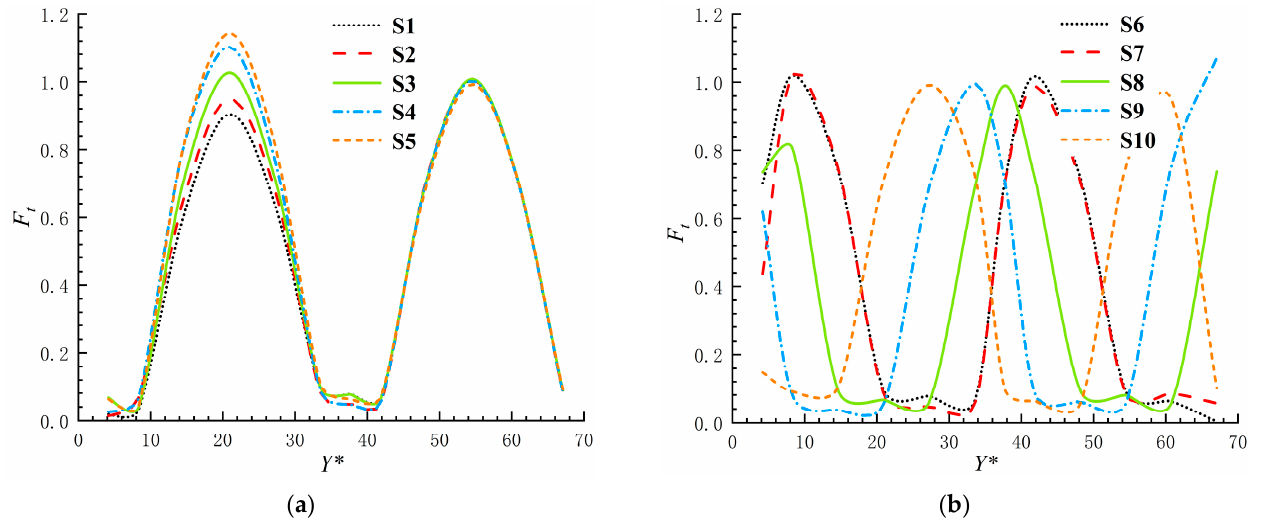
Figure 13. Cross-sectional averaged transverse flux of concentration along the channel. ( a ) Case S1–S5; ( b ) and Case S6–S10.